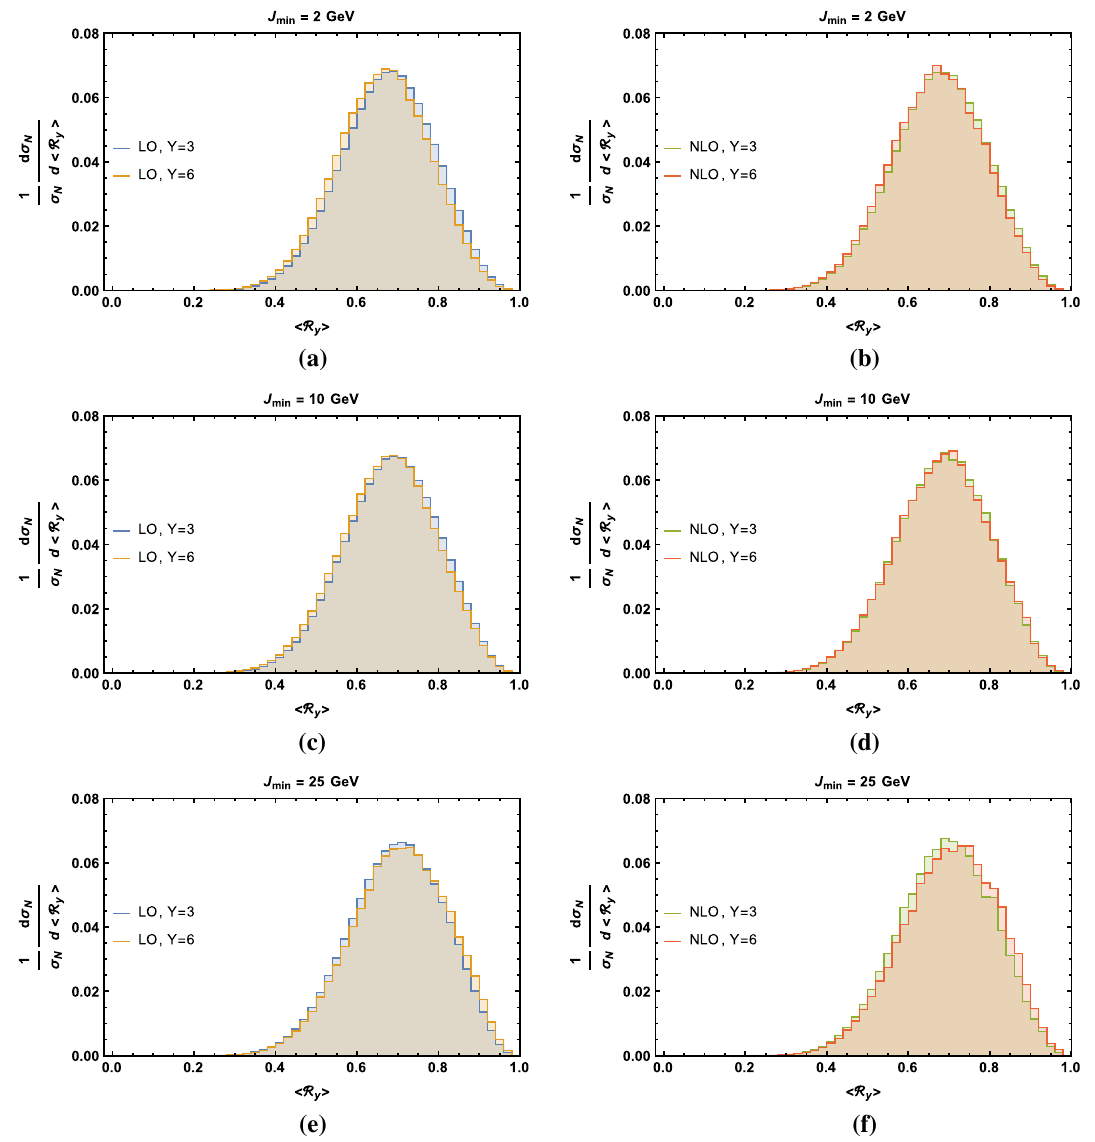
Fig. 4 Normalized (cid:10) R y (cid:11) at LO (left) and NLO+DLs (right) for multiplicity N = 5, rapidity difference Y = 3 , 6 and J min = 2 (top), J min = 10 (middle), J min = 25